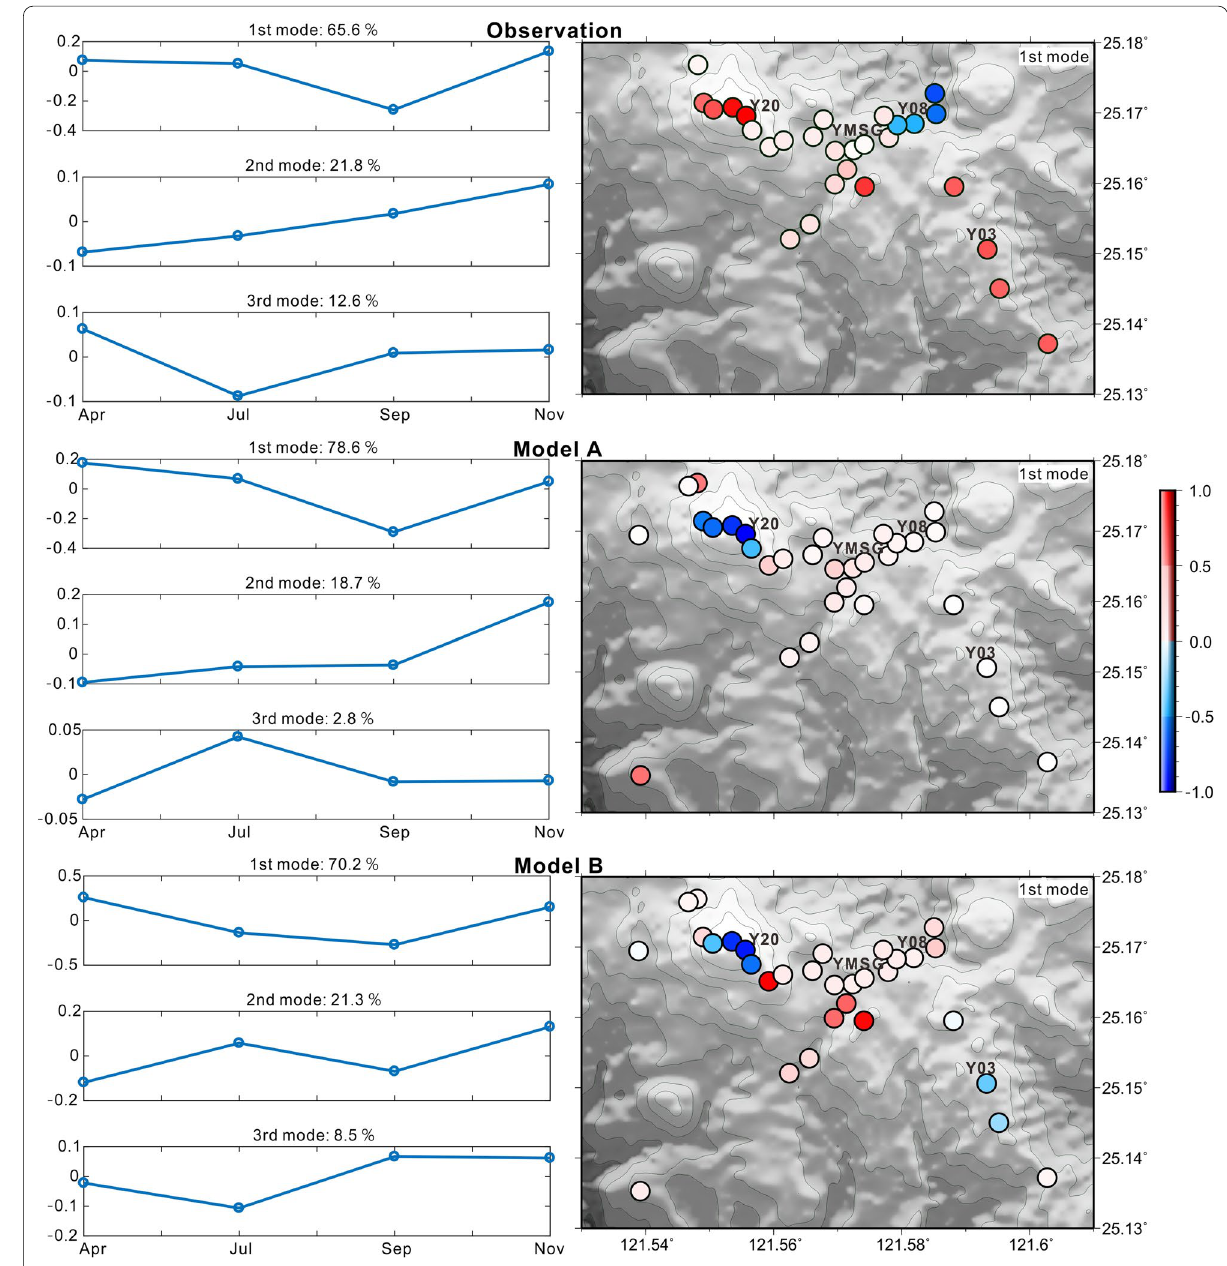
Fig. 10 Three principal modes of variances (or variabilities) from the EOF analyses of the observed gravity changes (top) and the simulated gravity changes from Model A (middle) and Model B (bottom). The right column shows the variabilities of the first modes. The variances are unitless because of normalization. A negative variability indicates a negative